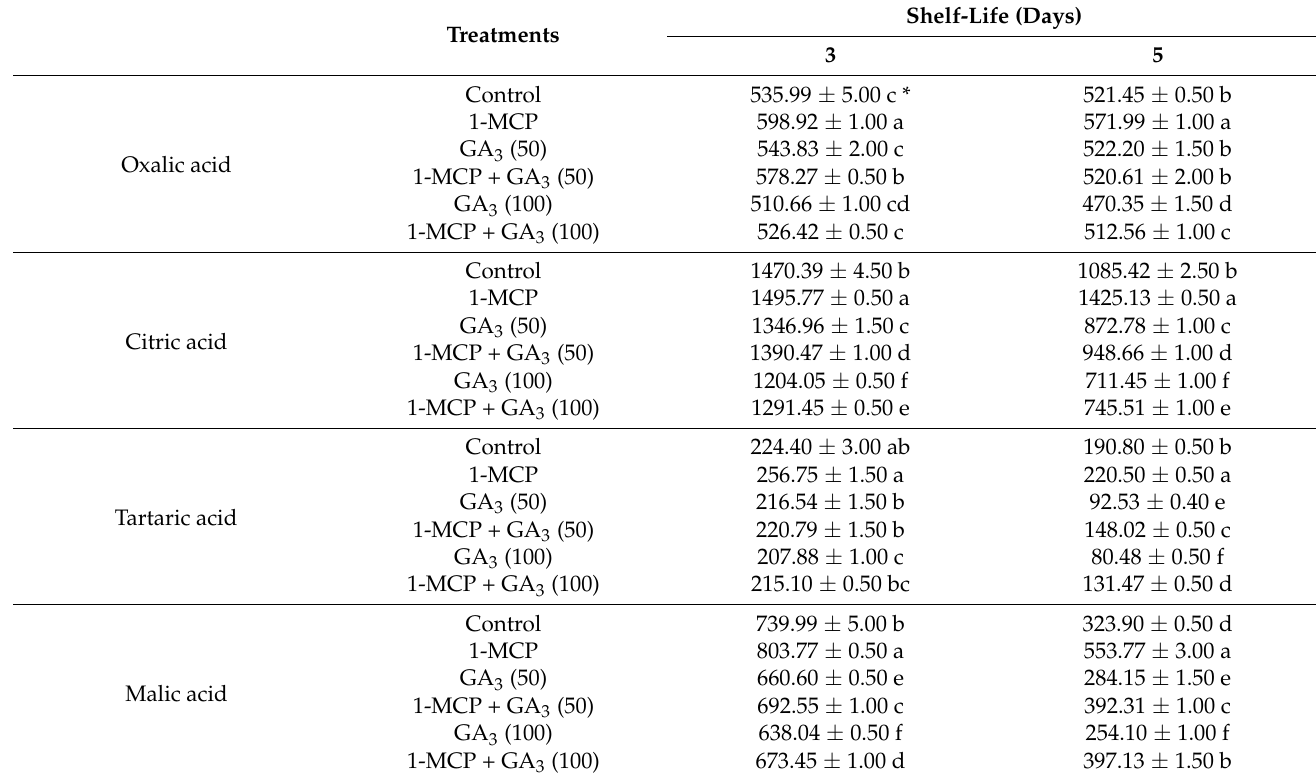
*: Values are mean value ± standard deviation. n = 3. The difference among the means indicated with the same lower-case letter in columns was not significant ( p ≤